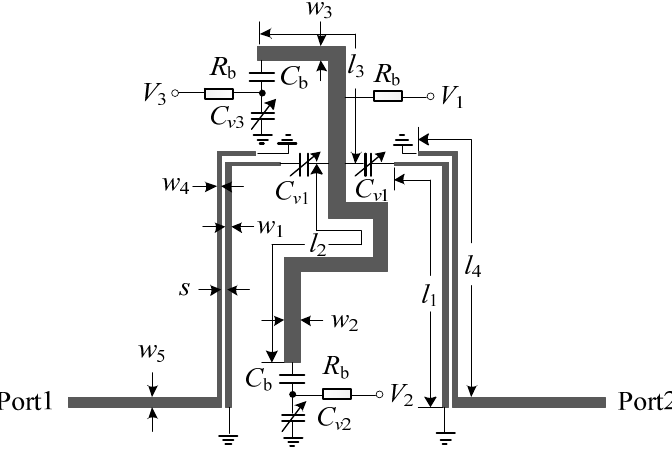
Figure 9. Schematic diagram of the proposed filter.